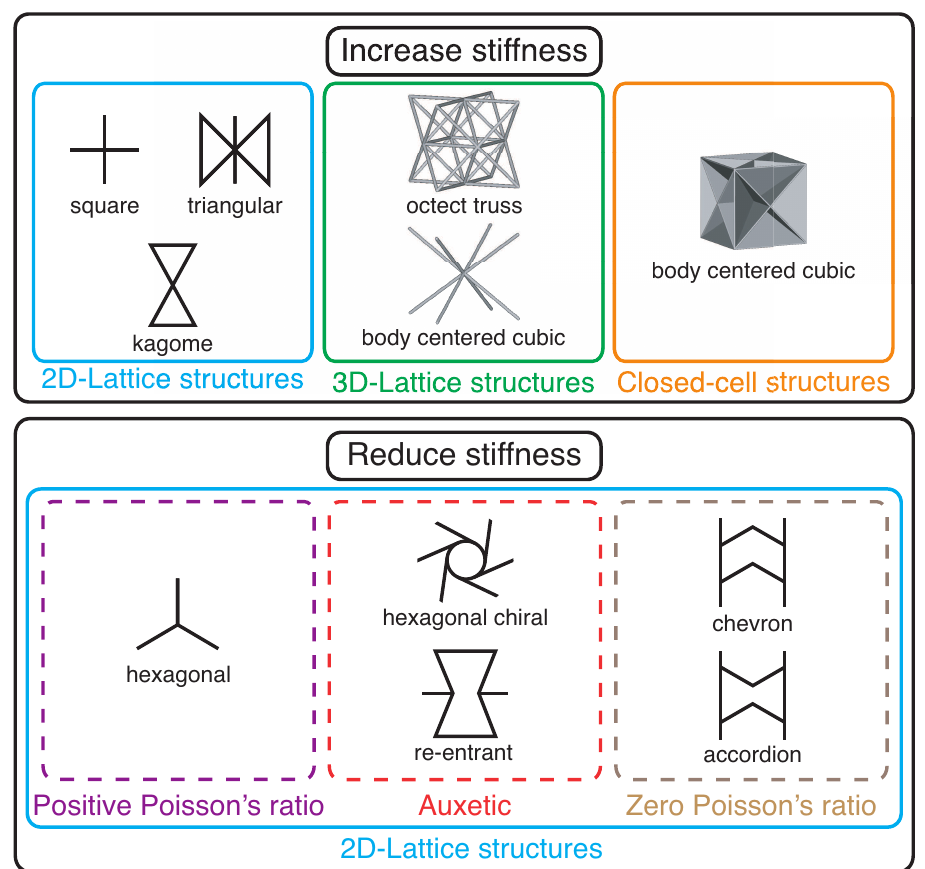
Figure 6. Unit cells of some of the most commonly used cellular structures for tailoring stiffness. Unit cells for increase stiffness are categorized in: 2D lattice structures (square [92], triangular [93], and kagome [100]), 3D-lattice structures (octet truss [94], and body centered cubic [81]), and closed-cell structures (body centered cubic [96]). Unit cells for reduce stiffness are only in the category of 2D lattice structures, and they are separated according to their Poisson’s ratio behavior in: positive Poisson’s ratio (hexagonal [119]), auxetic (hexagonal chiral [116], and re-entrant [117]), and zero Poisson’s